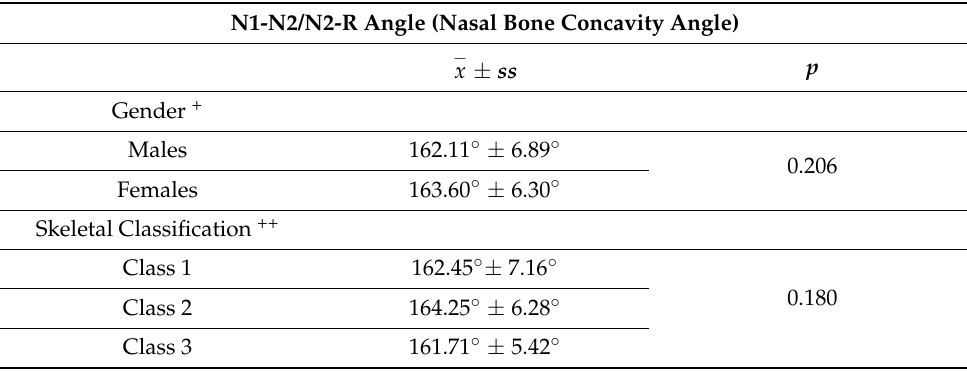
Table 5. Comparison of nasal bone concavity angle with skeletal malocclusions and